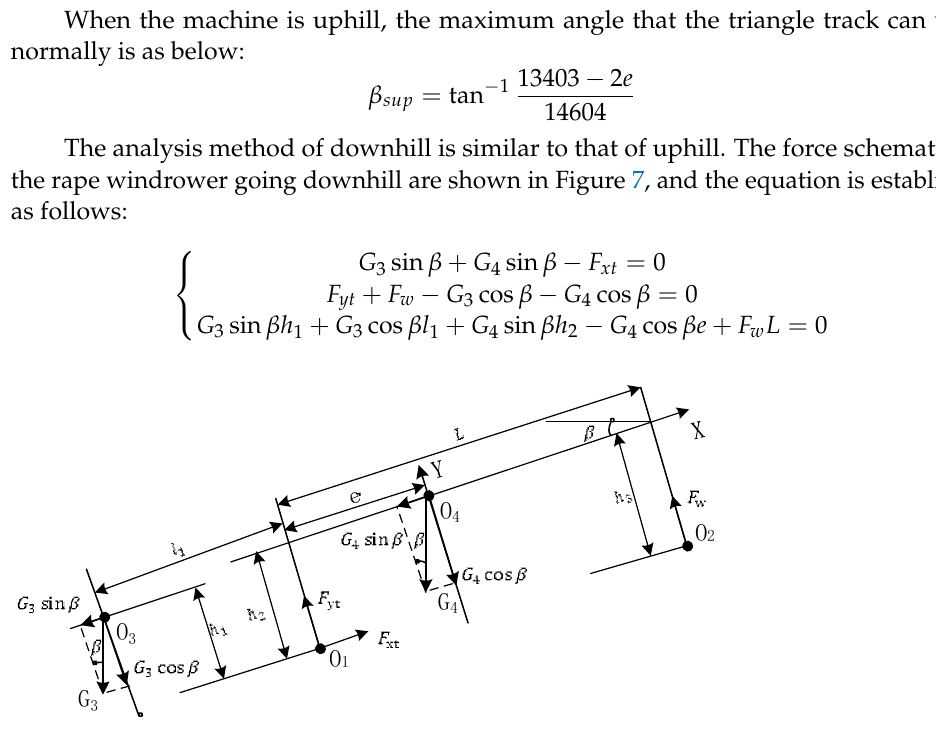
Figure 7. Force schematics of the rape windrower when driving down the slope.